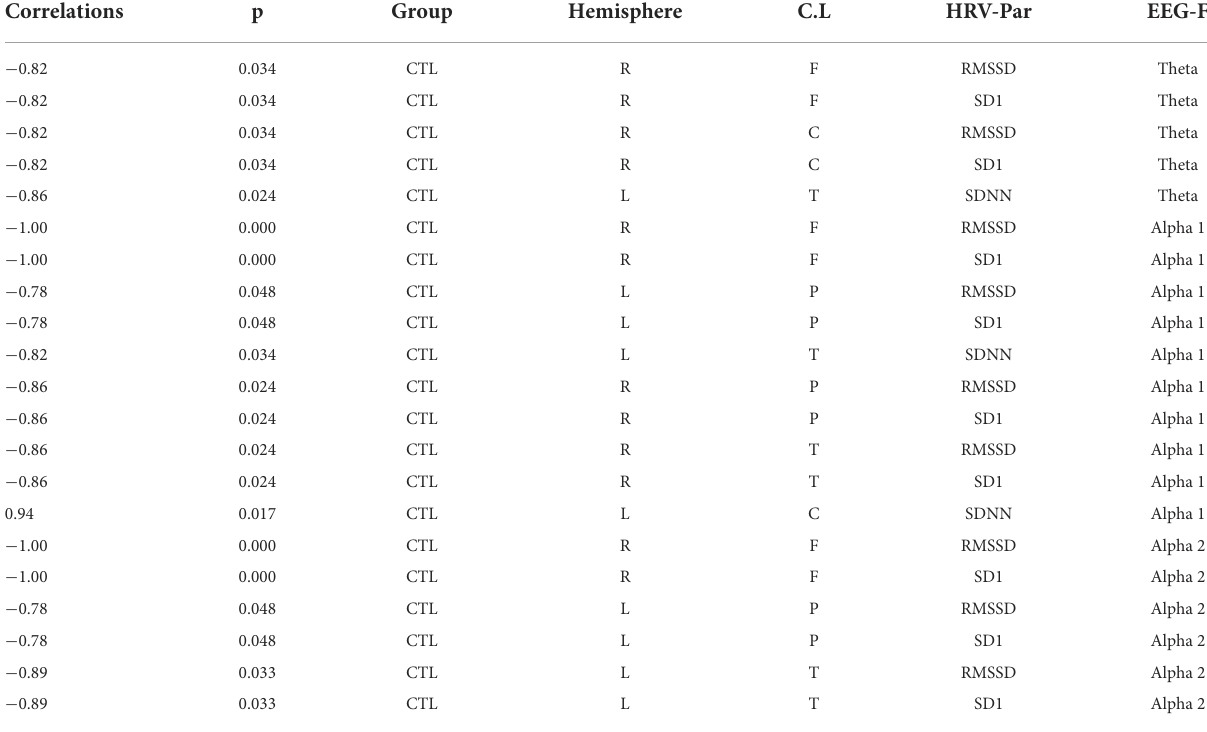
TABLE 3 Spearman correlations calculated between EEG power and HRV parameter for the control epilepsy group. Correlations